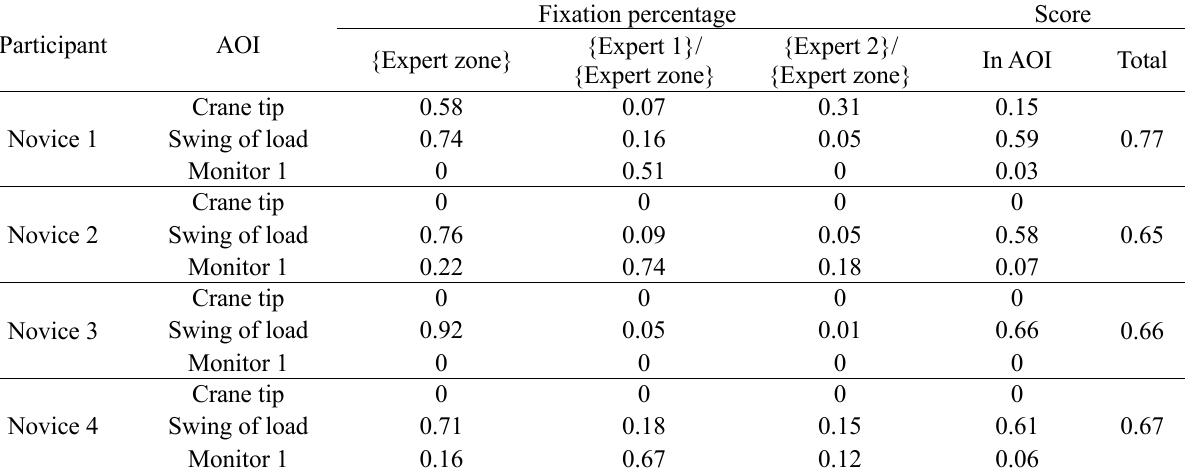
Table 2. Scores of eye behavior for novices in target stage one.